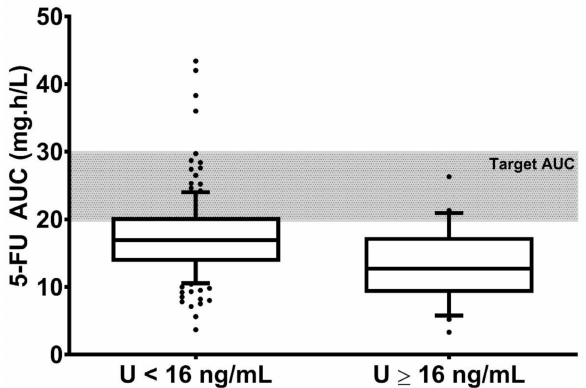
Figure 3. Distribution of 5-FU area under the curve (AUC) between patients with uracilemia < 16 ng / mL and ≥ 16 ng / mL. Limits of the boxplots are 10–90